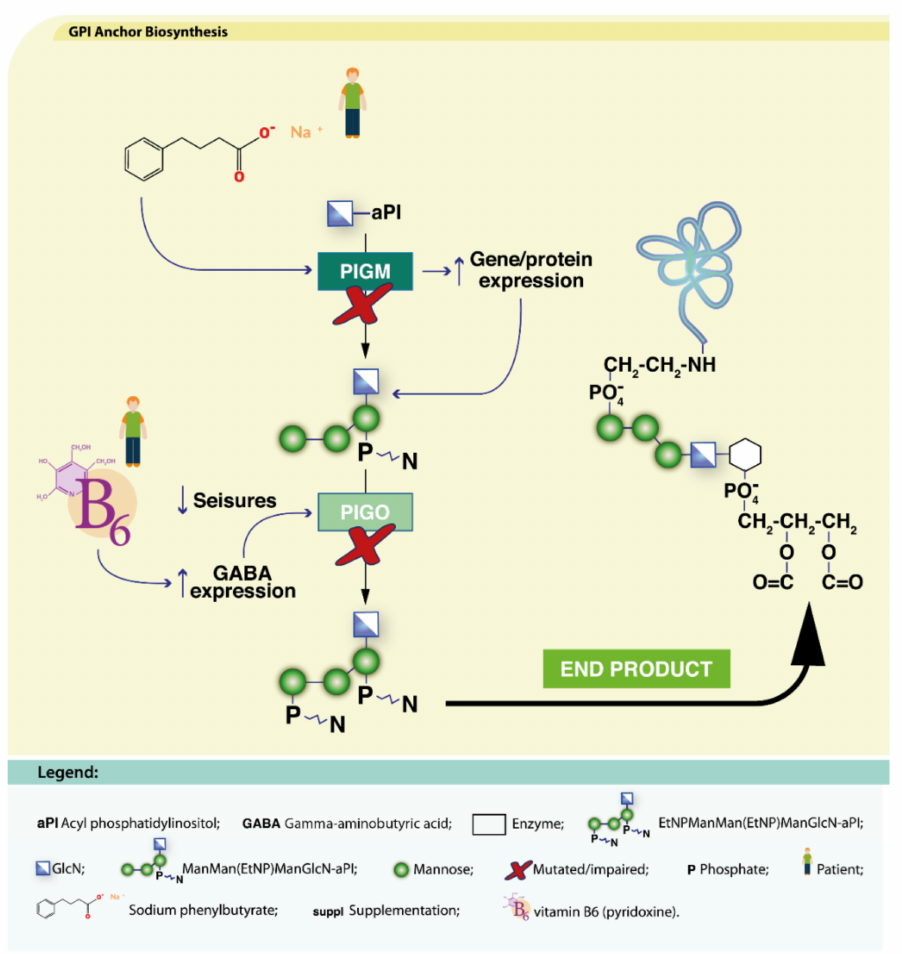
Figure 4. Dietary supplementation approaches under investigation for PIGM-CDG and PIGO-CDG. Vitamin B6 due to its ability to increase GABA expression has been tried for PIGO-CDG (blue arrows). Sodium butirate, which can increase PIGM expression, has been tried for PIGM-CDG (blue arrow). These therapeutic approaches aim to recover the metabolic pathways (black arrows) and ultimately, the final end product (bold black